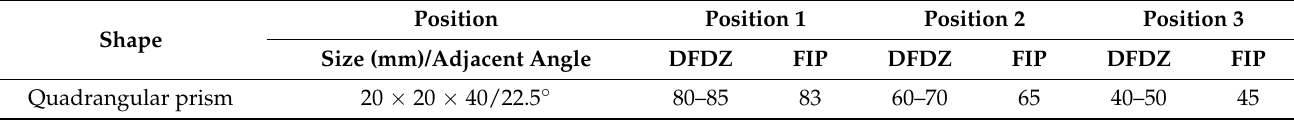
Table 1. The DFDZ and FIP for quadrangular prism object made of copper in three orientations.